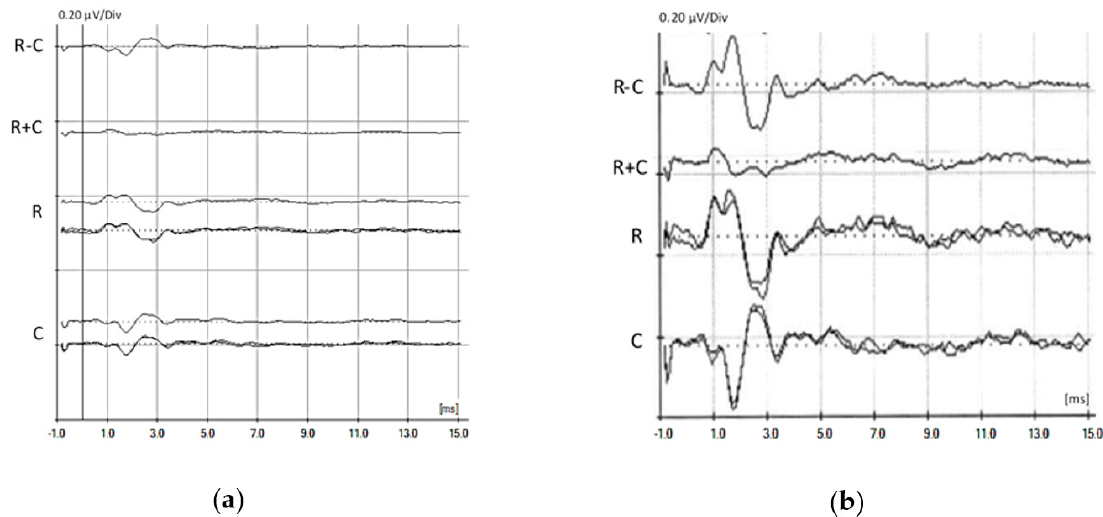
Figure 5. Auditory brainstem responses (ABRs) in a 26-week preterm newborn with auditory